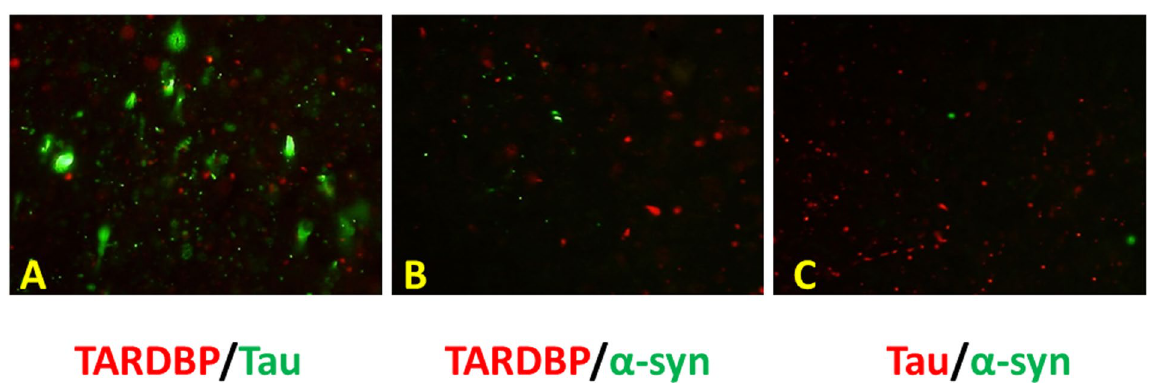
Figure 6. Immunofluorescent double-staining of accumulated proteins in the temporal lobe in GRN mutation case. Phosphorylated TDP-43, α -synuclein and tau immunoreactivity were obserbed in the temporal lobe of GRN mutation case 4. pTDP-43 (red)/pTau (green) ( A ), pTDP-43 (red)/p α -synuclein (green) ( B ) and pTau (red)/p α -synuclein (green) ( C